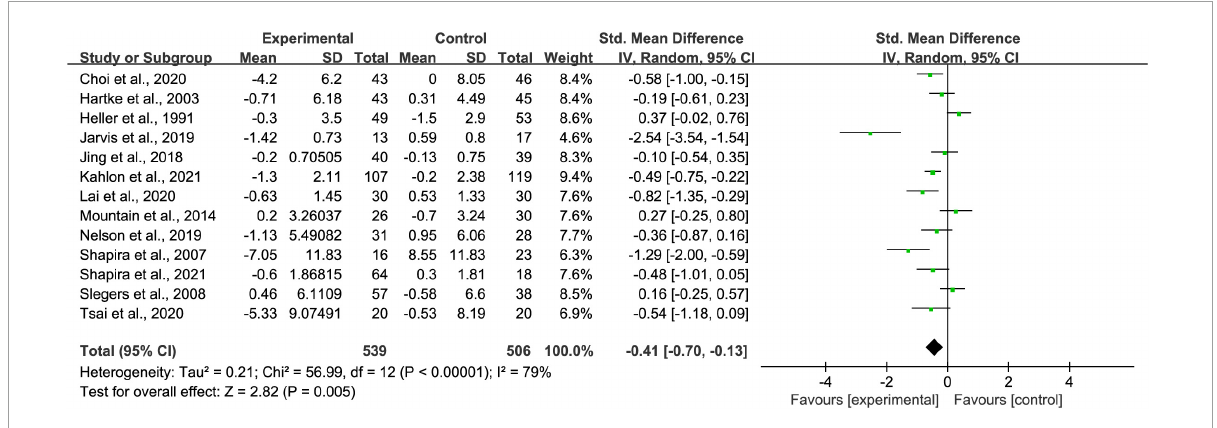
FIGURE3 Comparisons of remotely delivered intervention and all controls on the basis of loneliness scores.